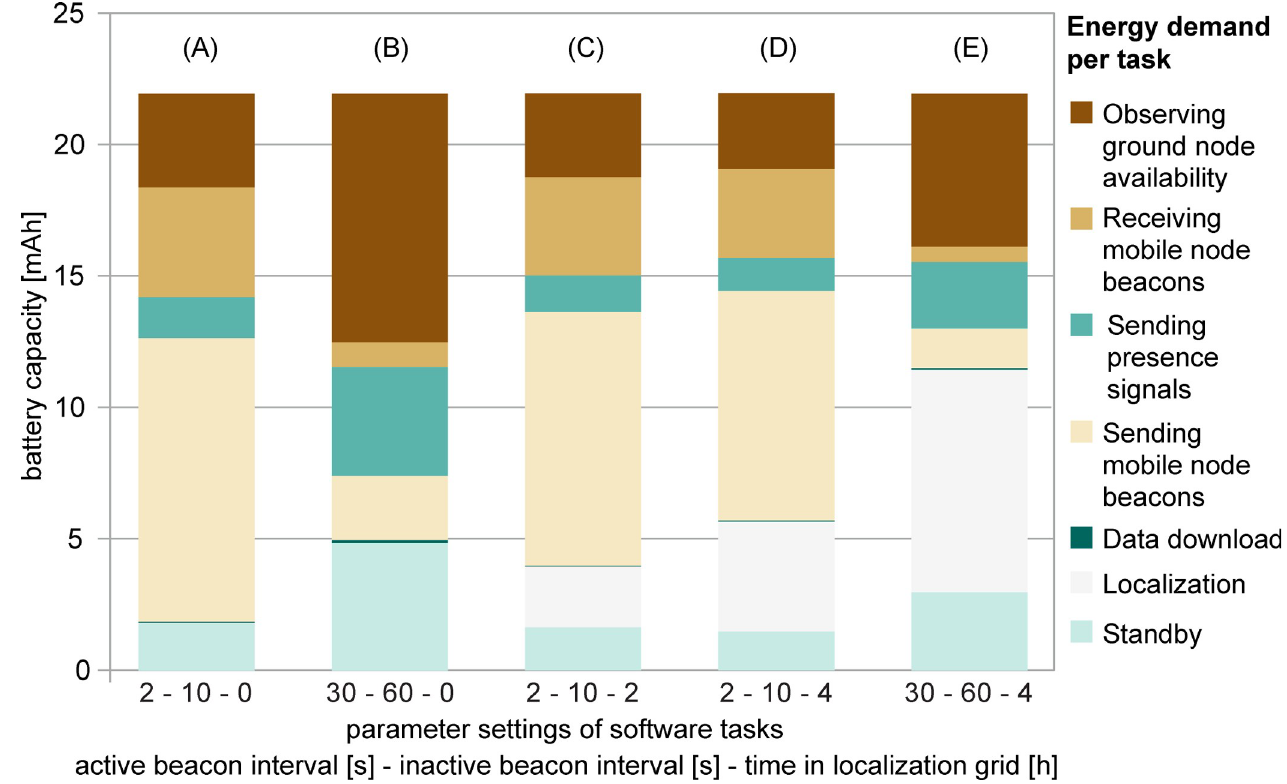
Fig 5. Energy distribution of software tasks of a mobile node powered by a 22 mAh battery. Energy demand per software task depends on parameter settings for active/inactive beacon interval (s) and amount of time an animal spends in the localization grid (h). The energy demand is shown for the 7 major software tasks. Zero time in the localization grid (A, B) refers to a pure proximity sensing scenario. Data underlying this figure have been archived by GFBio (https://doi.org/10.7479/vd6t-7a92).